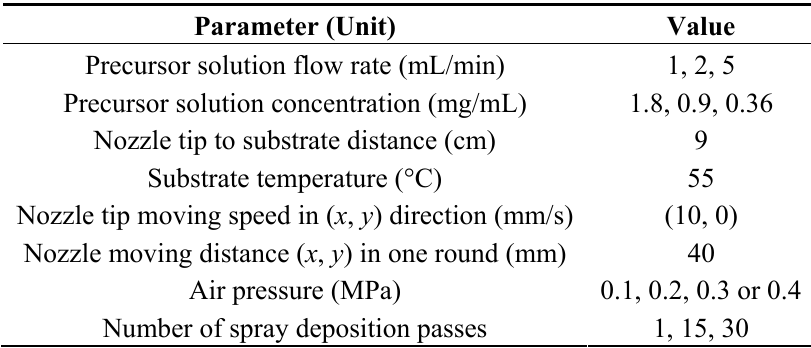
Table 1. Process parameters in spray